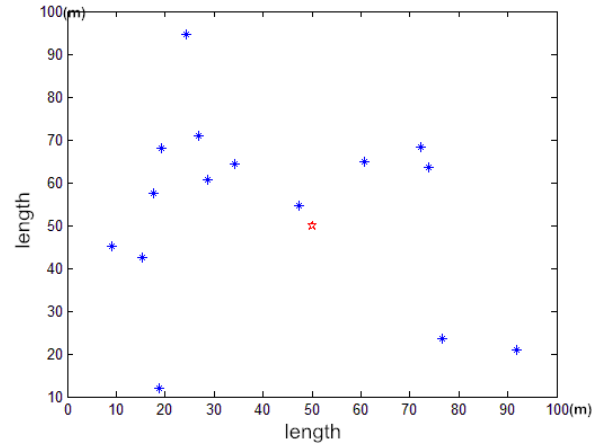
Figure 4. Simulative HAN with random distributed users.